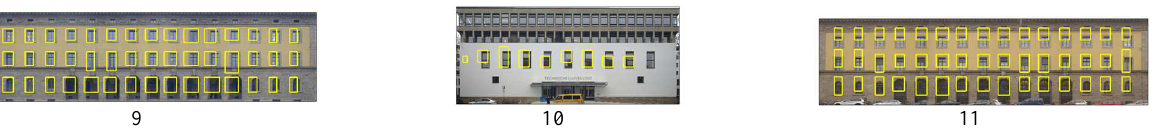
Figure 7. Textures and reconstructed windows for façade parts 1 to 8 (from left to right)